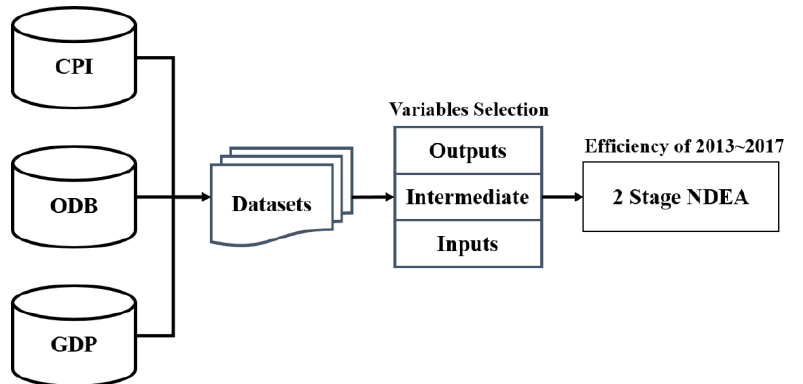
Figure 3. Efficiency Analysis Scenario.